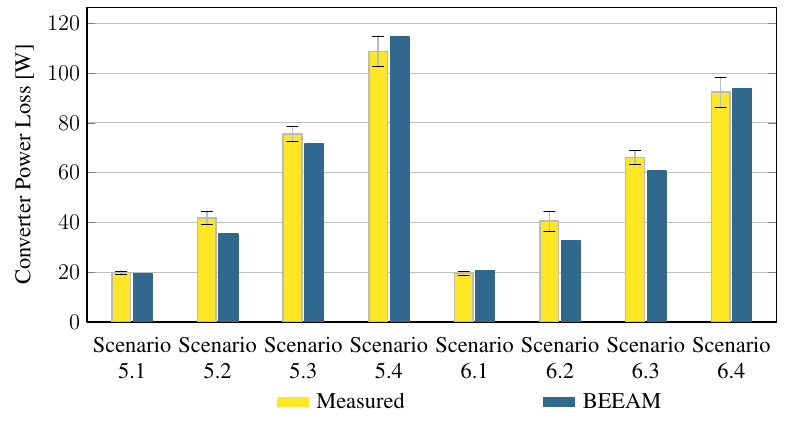
Figure A18. Predicted versus measured converter loss, Scenarios 3 and 4.